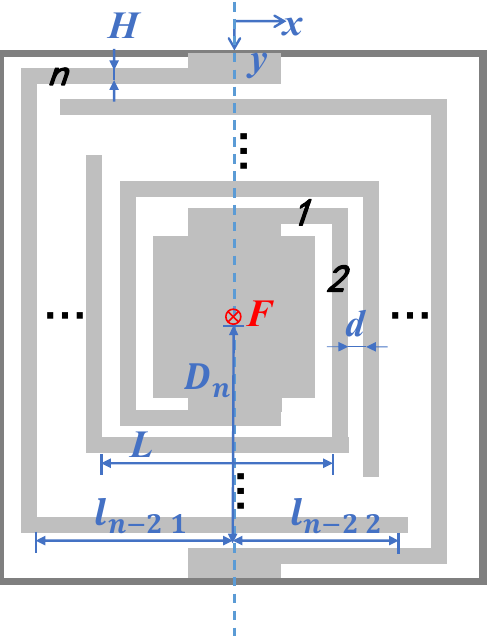
Figure 4. Diagram defining the dimensional variables of the square pattern. As L (cid:29) W + d , the beams in one turn can be considered as four straight beams with equal lengths. Each beam can be divided into l i 1 and l i 2 with the vertical line as the dividing point. So,